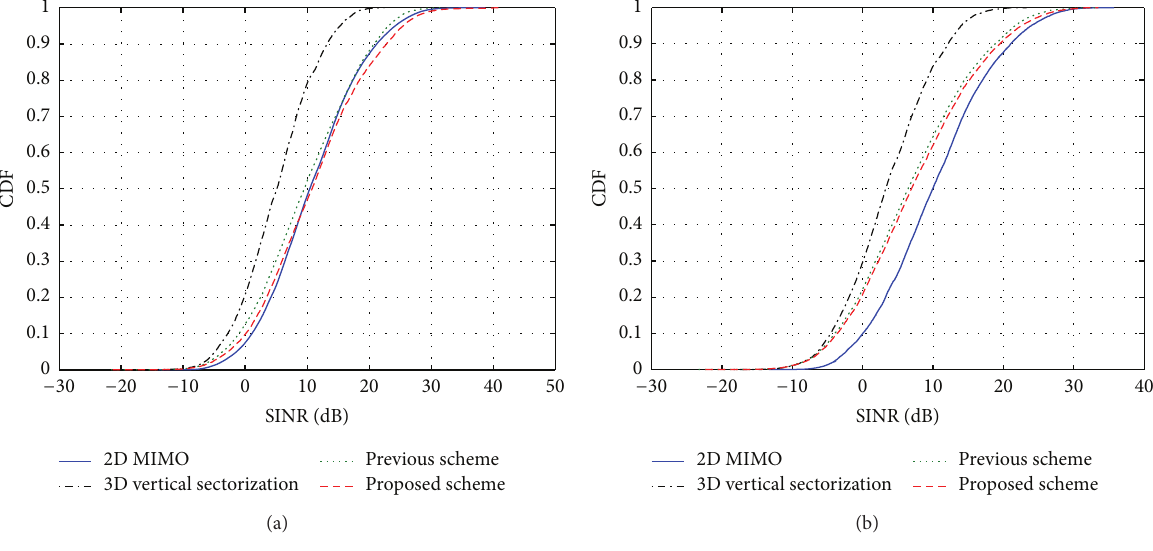
Figure 8: System level results of UEs’ receive SINR CDF for 2D MIMO, 3D vertical sectorization, previous scheme, and proposed scheme: (a) 4 × 2 288 m scenario; (b) 4 × 2 500 m